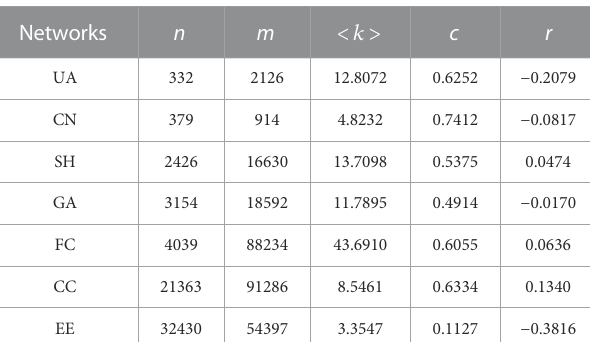
TABLE 1 Seven practical networks used for experimental analysis.